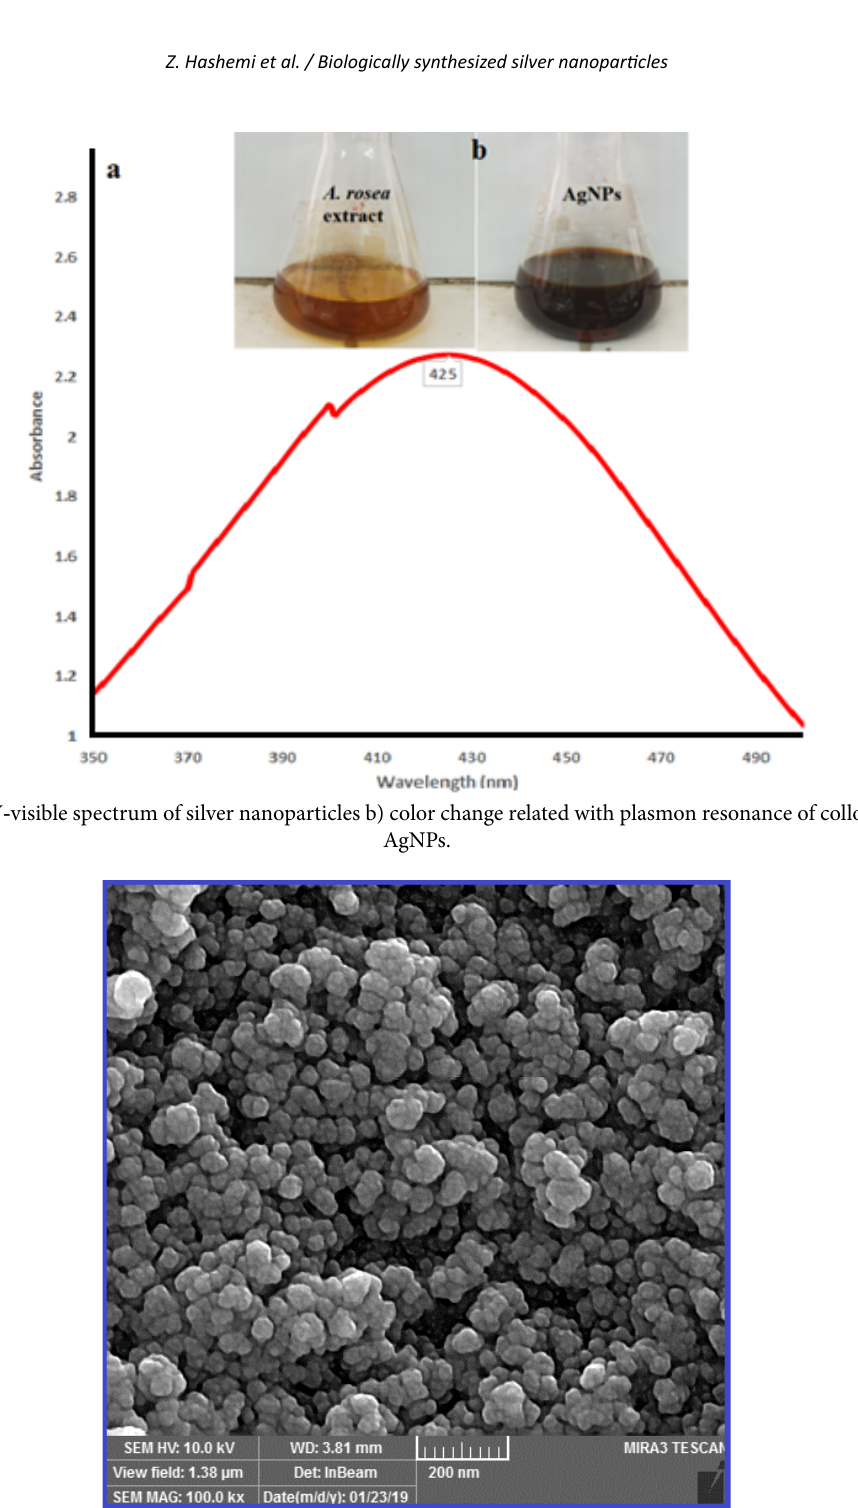
Fig. 2. Surface morphology of the synthesized silver nanoparticle from the aerial extracts of A. rosea by